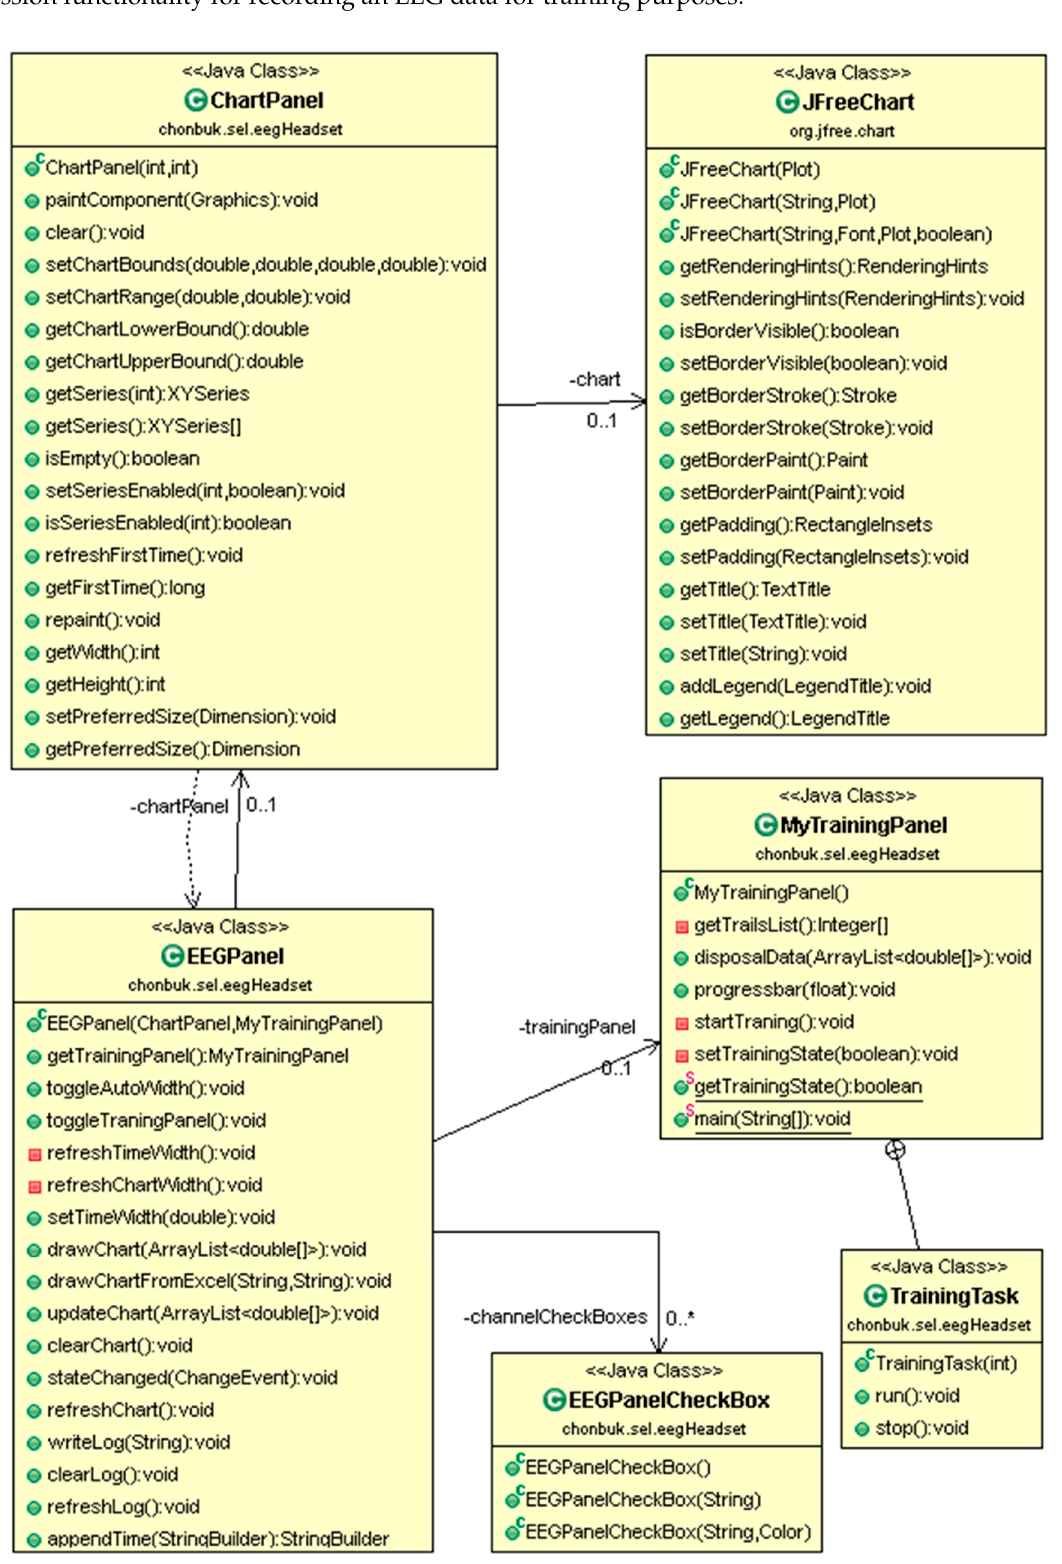
Figure 5. Class diagram for headset package and its functionality for visualizing EEG data and user training management.